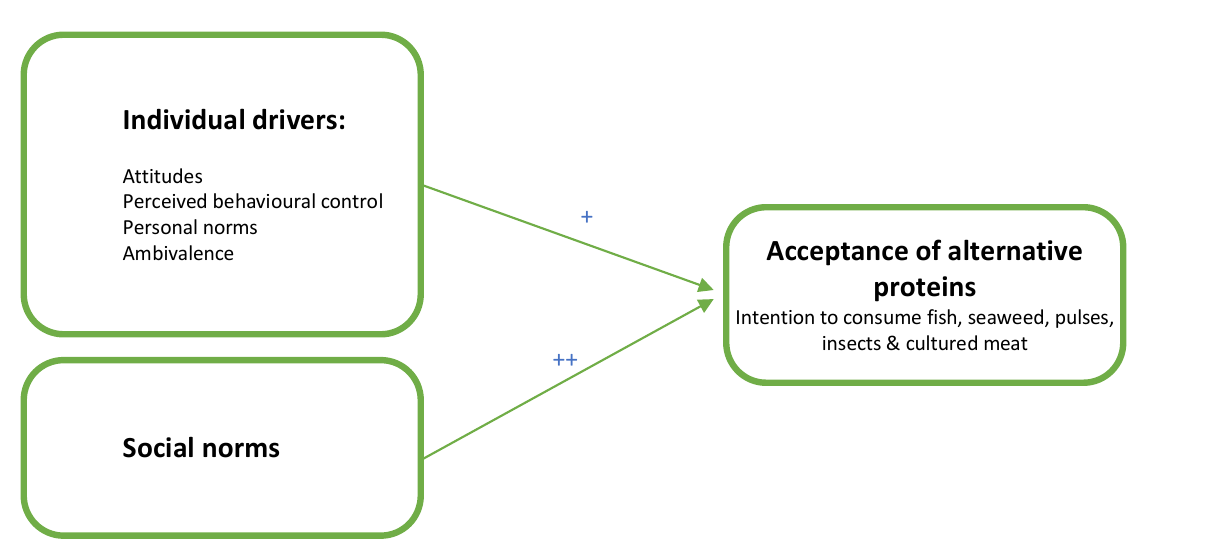
Figure 1. Conceptual model of the proposed associations. Note that we propose a stronger associa- tion (++) for social norms with acceptance compared to individual drivers (+)